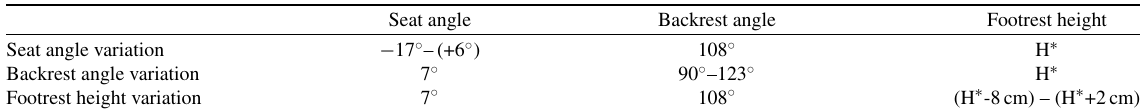
Table 1 The seat angle, backrest angle and footrest height for the different experiments. The diagonal of ranges were the parameters changed in each of